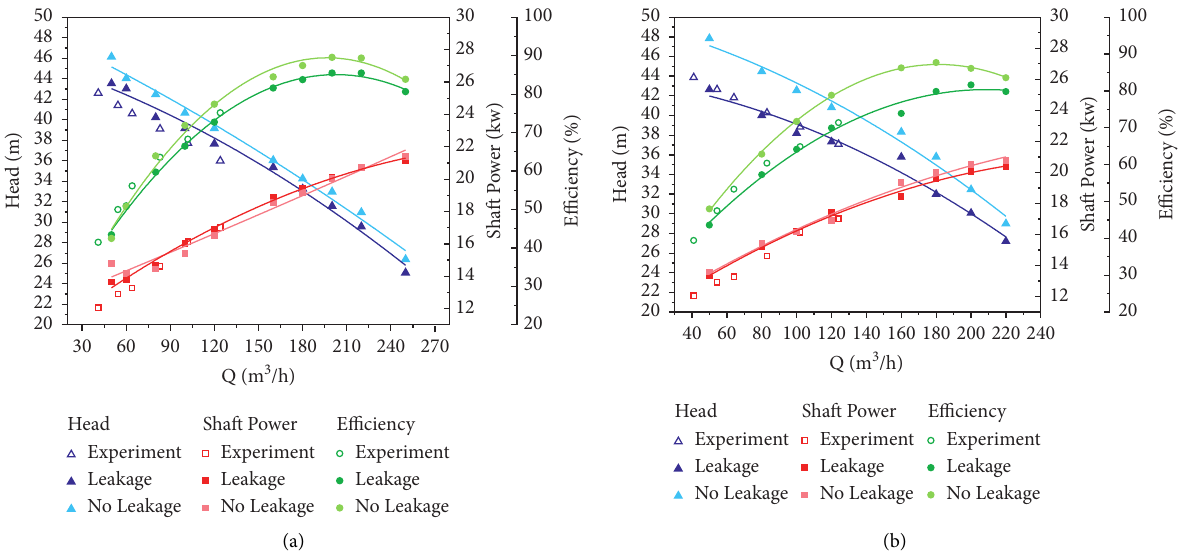
Figure 6: Comparison of the hydraulic performance between experiment and simulation: (a) water condition and (b) slurry condition.